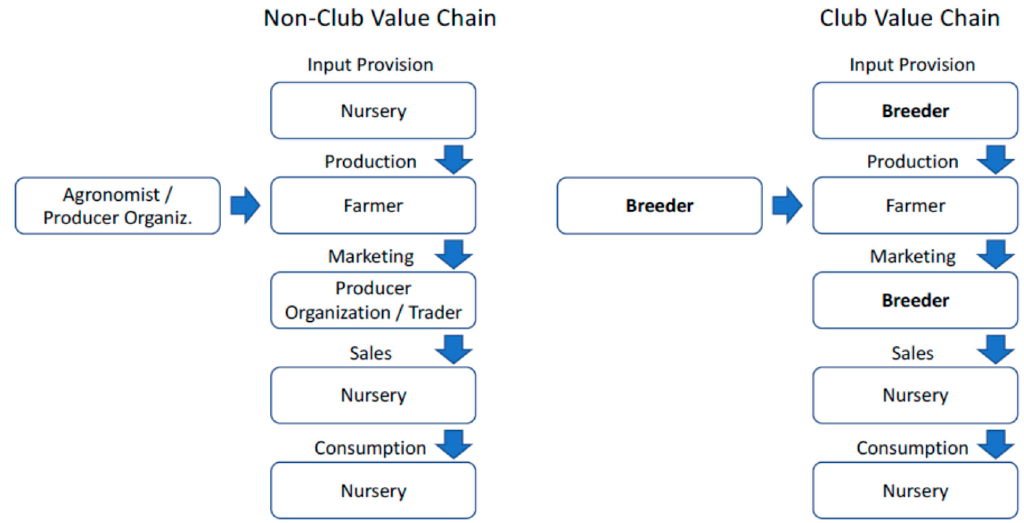
Figure 2. A stylized representation of the Agro Pontino Kiwifruit value chains.